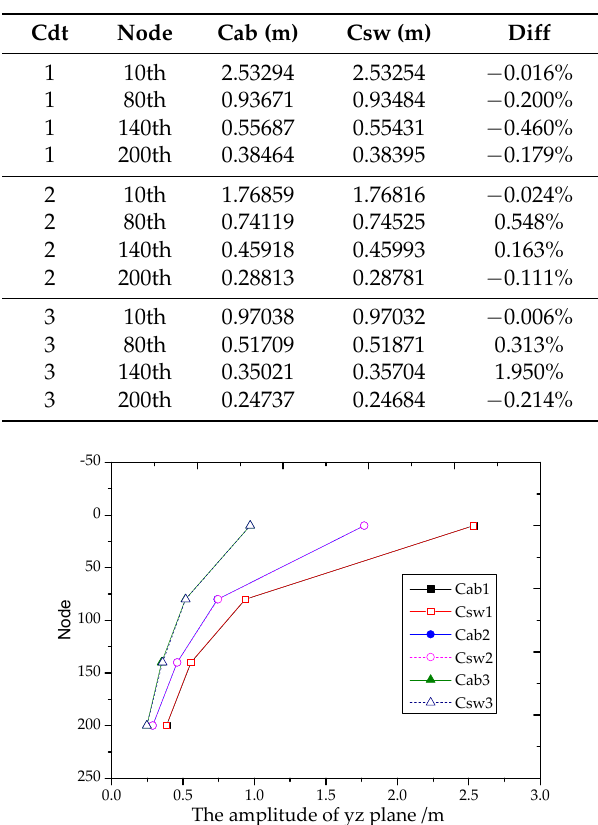
Table 6. Amplitude and difference of yz plane swing in different conditions.